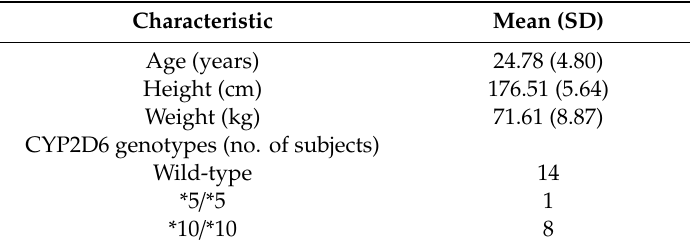
Table 1. Demographic characteristics ( n =